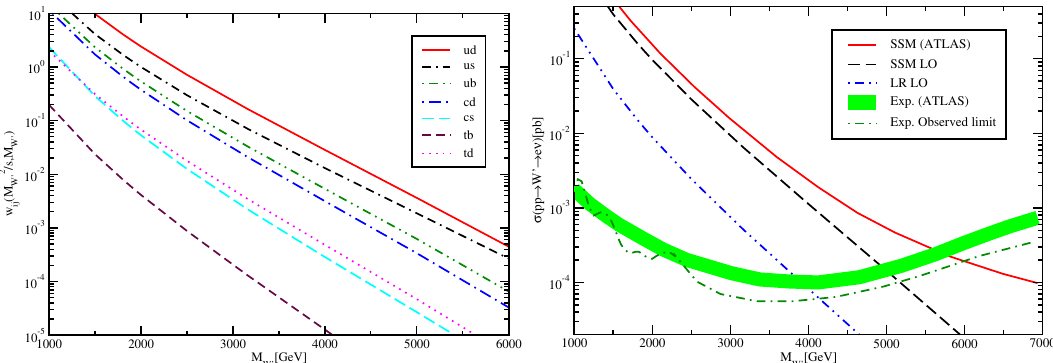
Figure 7 . (Left) The quantity w ij ( M 2 =s; M W 0 ), eq. (6.6) for up and down type quarks of various W 0 generations as a function of the W 0 mass. (Right) pp ! W 0 ! e(cid:23) cross section in the Sequential Standard Model (\SSM LO") and in the LR model (\LR LO") at LO. Also shown are the SSM result from ATLAS [16] as well as their observed and expected upper limits at 95%